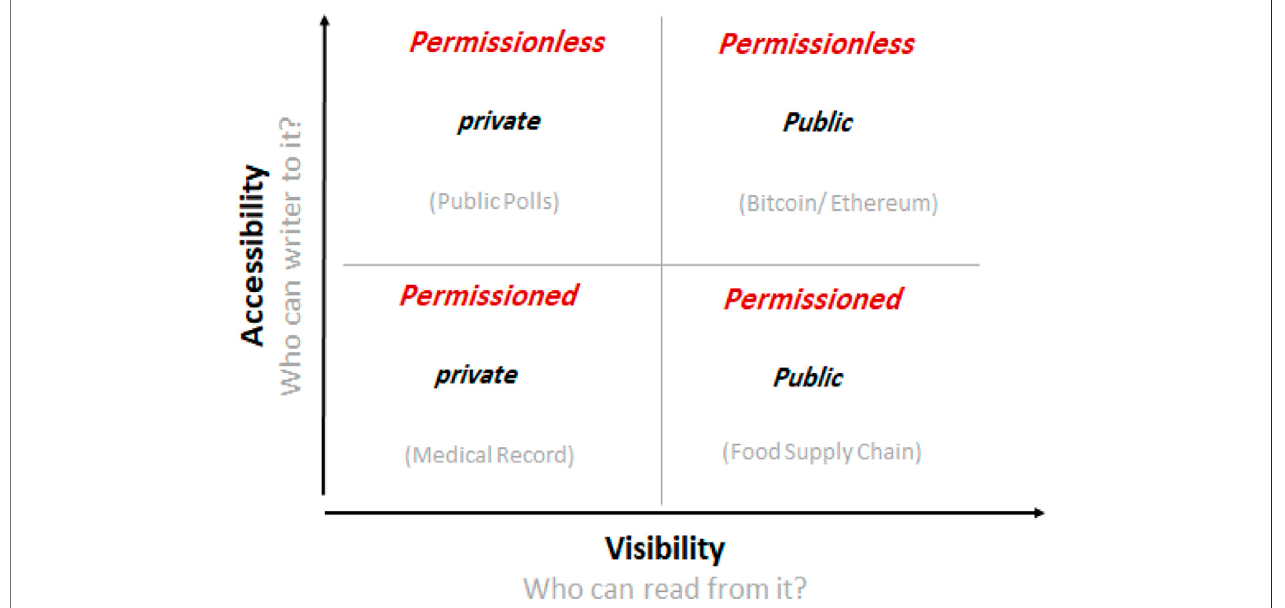
FIGURE 3 | Blockchain systems accessibility and visibility matrix (Alsalamah and Nuzzolese, 2020).